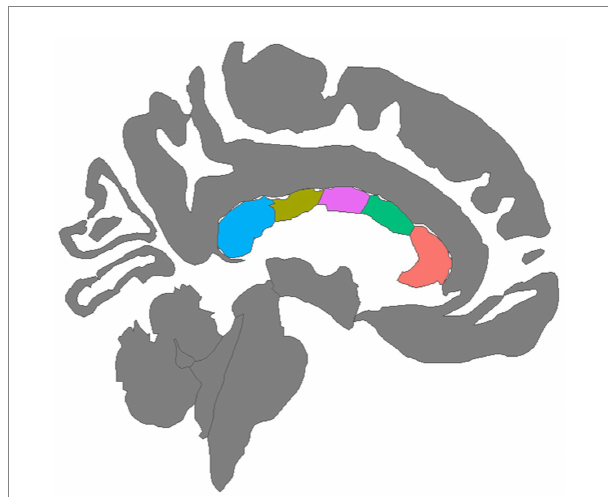
FIGURE 1 Mid-sagittal view of five corpus callosum tracts generated by tractography: (left to right) Blue = Posterior, Olive = Mid Posterior, Purple = Central, Green = Mid Anterior, Orange =